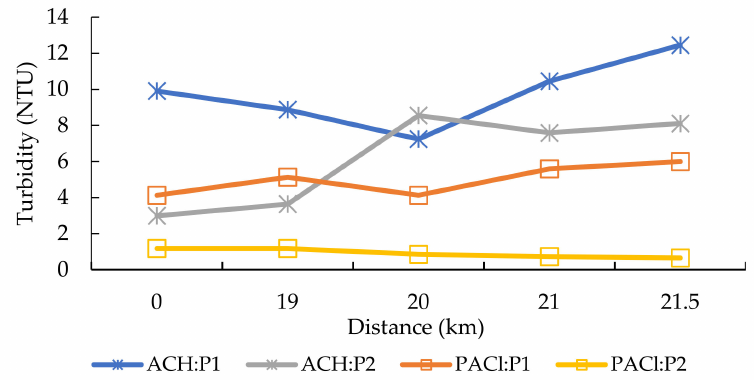
Figure 15. Increasing turbidity in the distribution